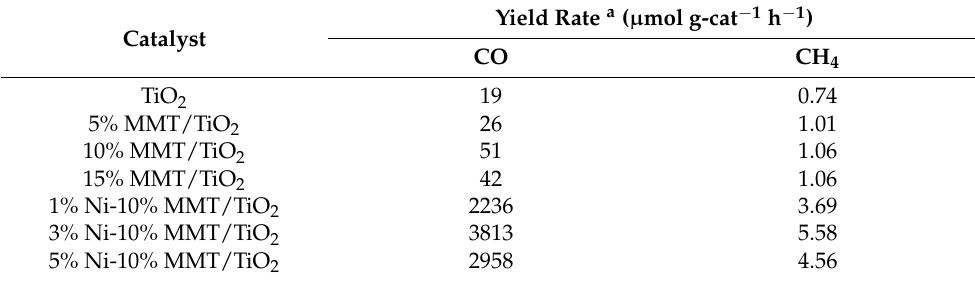
Table 5. Performance of Ni/MMT-modified TiO 2 with various loading amounts and references. Copyright (2019), reprinted from [35] with permission from Elsevier. CPSI stands for channels per square inch.